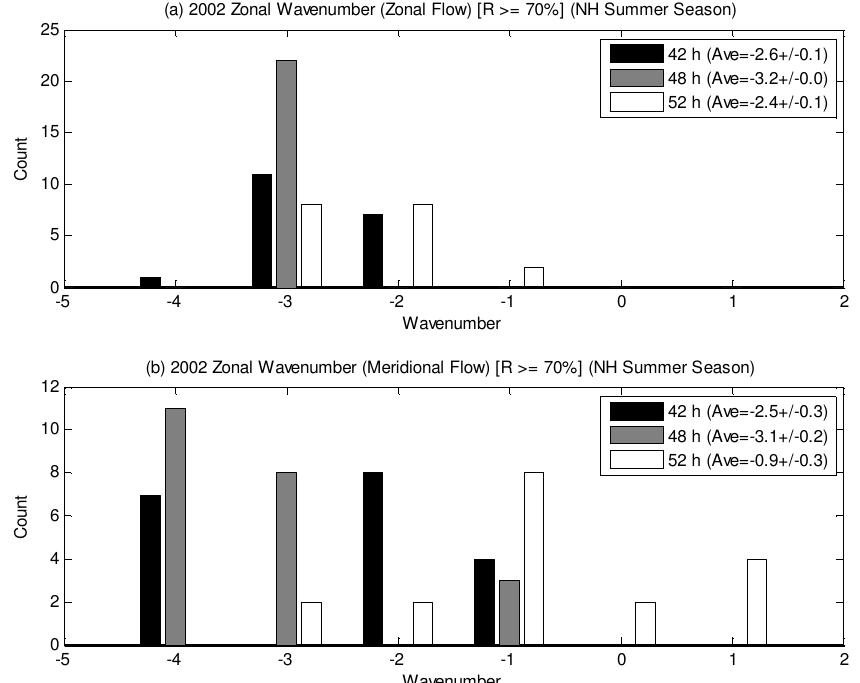
Figure 8. The distribution of the zonal wavenumber for the zonal and the meridional 42-, 48- and 52-h QTDW components in summer. Negative represents westward propagating waves.